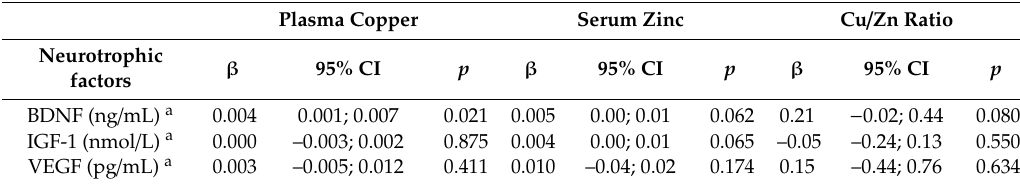
Table 3. Associations between plasma copper, serum zinc and Cu / Zn ratio with neurotrophic factors in older adults ( n =